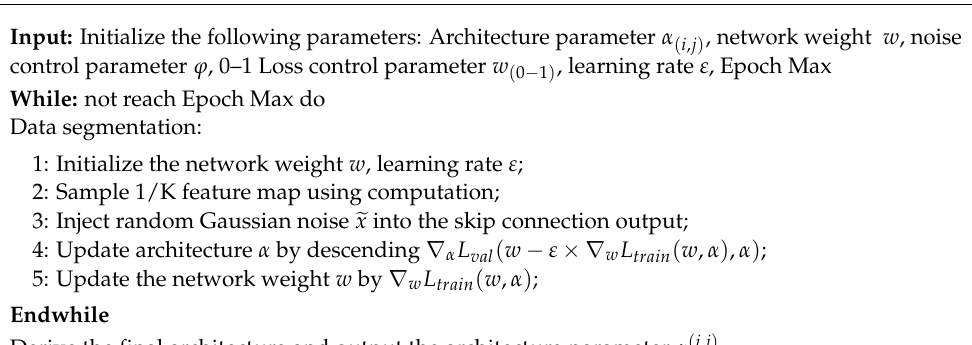
Algorithm 1 Remote Sensing DARTS for Scene Classification